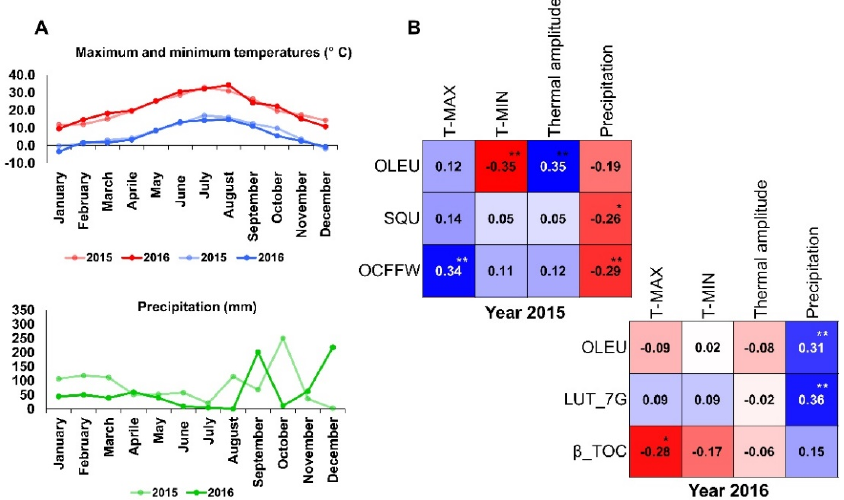
Figure 4. The monthly average temperatures and precipitation in two crop seasons ( A ). Red indi- cates maximum temperatures, and blue, minimum temperatures. Pearson’s correlation coefficients ( B ) between the hourly climate data and significantly correlated traits. Dark red and blue colors indicate significant data. Asterisks indicate ** p < 0.01 and * p < 0.05.